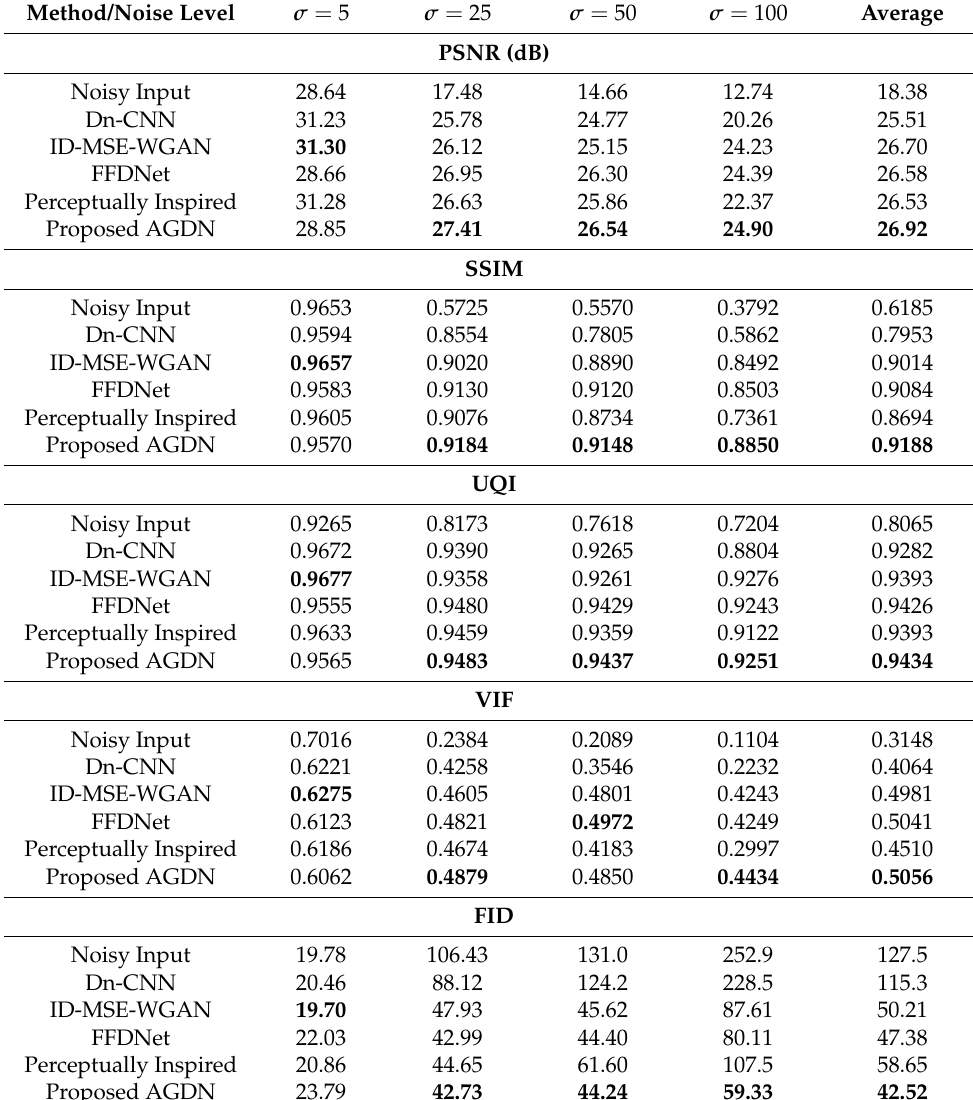
Table 9. Quantitative results of baseline methods with the proposed method on several noise levels. Bold results show good